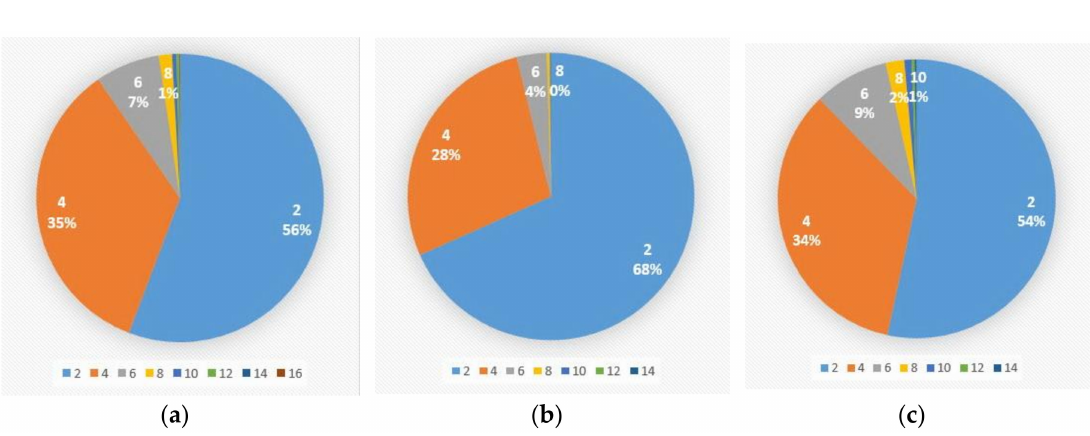
Figure 8. Distribution of dimples by their equivalent diameters: 2—from 0 to 2 µ m; 4—from 2 to 4 µ m; 6—from 4 to 6 µ m; 8—from 6 to 8 µ m; and 10—from 8 to 10 µ m for static deformation ( a ), DNP1 ( b ), and (DNP2) ( c